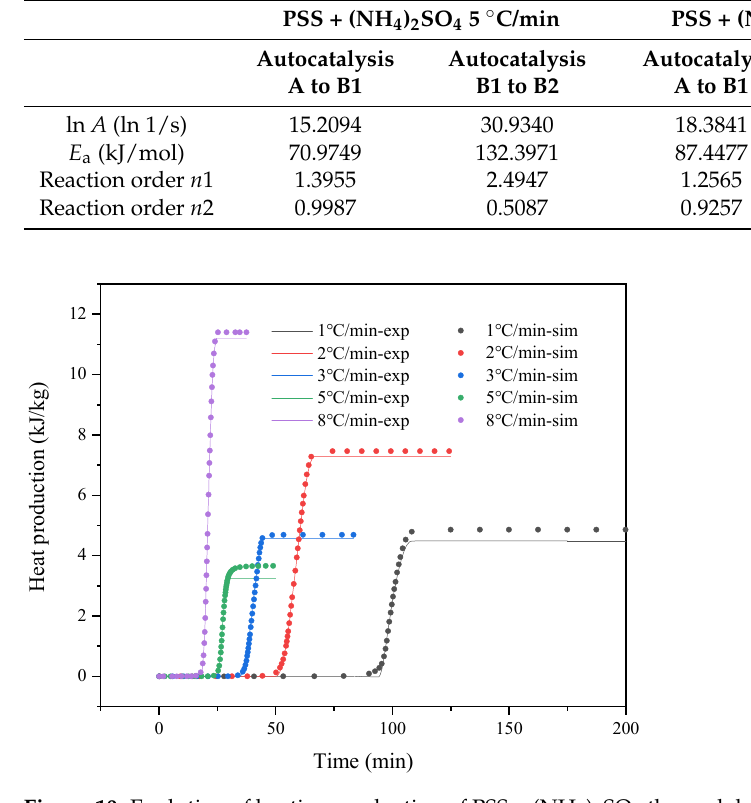
Figure 10. Evolution of heating production of PSS + (NH 4 ) 2 SO 4 thermal decomposition reaction with time in experiment and